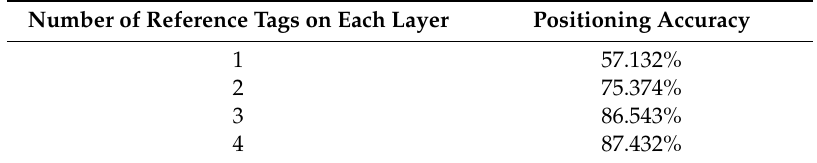
Table 1. Influence of the density of the reference tags on the accuracy of plane positioning.